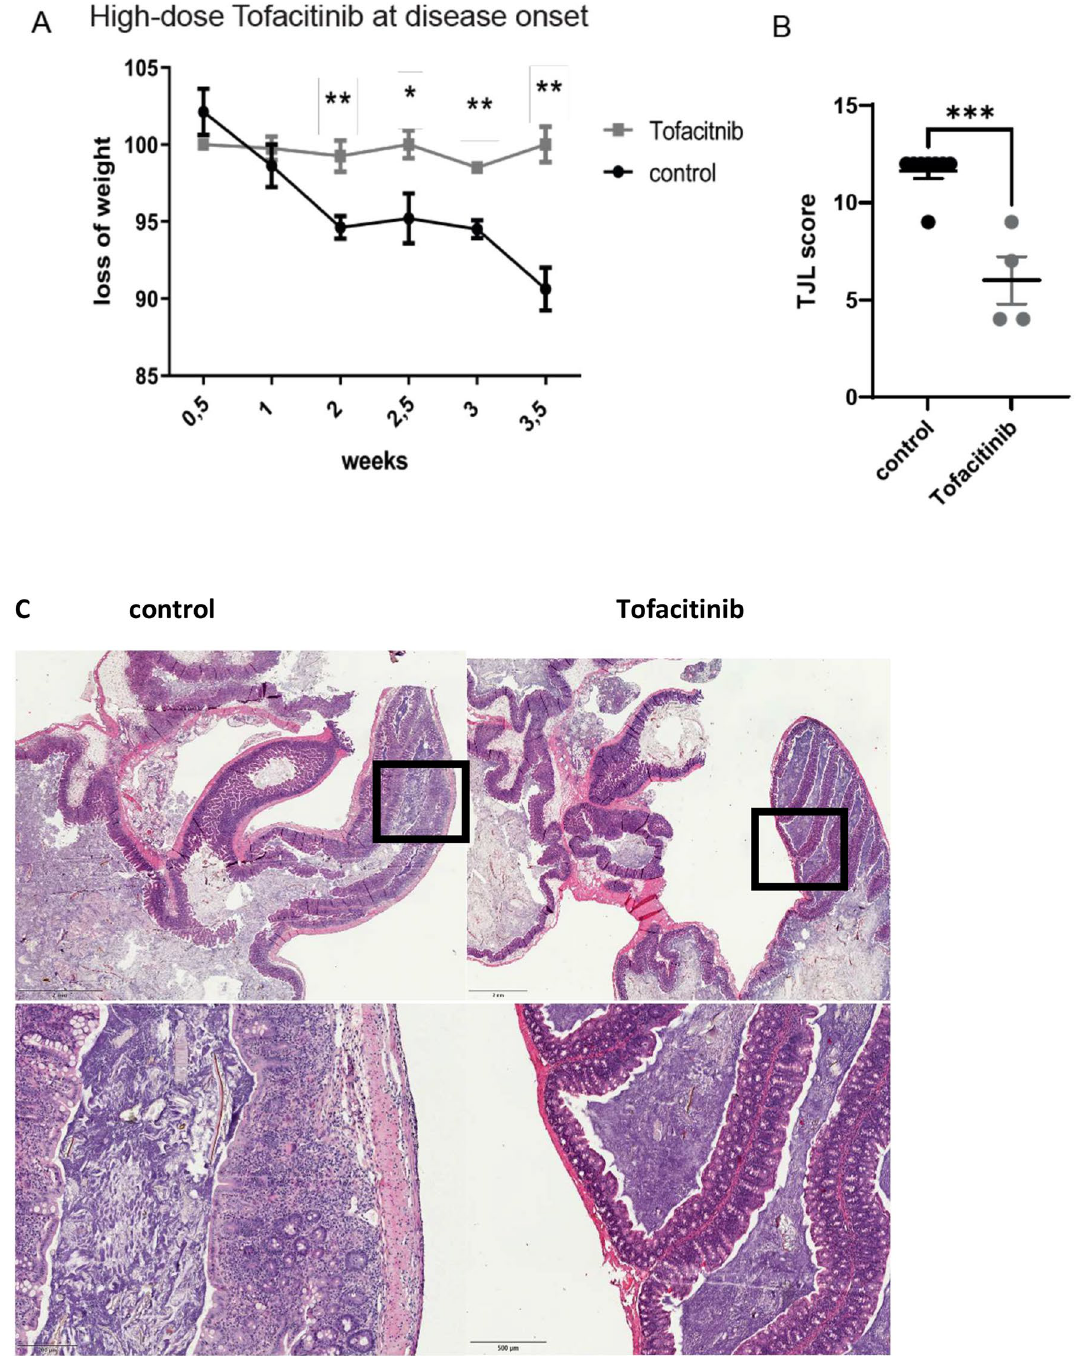
Figure 6. Tofacitinib treatment after onset of colitis reduces weight loss and intestinal inflammation. ( A ) Body weight as a percent of starting weight (N = 8 control mice, 4 Tofacitinib-treated mice, two-tailed unpaired t-tests were used, one experiment, ** = 0.0044, * = 0.0482, ** = 0.0011, ** = 0.0014). ( B ) Results of histological TJL (The Jackson Laboratory Score) scoring of colon sections. ( C ) Representative histology of colon tissue (left: control, right: Severity: Focally small or widely separated multifocal areas of inflammation limited to the lamina propria were graded as mild lesions (1). Multifocal or locally extensive areas of inflammation extending to the submucosa were graded as moderate lesions (2). If the inflammation extended to all layers of the intestinal wall or the entire intestinal epithelium was destroyed, lesions were graded as severe (3). Hyperplasia: Mild hyperplasia consisted of morphologically normal epithelial lining that was at least twice as thick (length of crypts) as adjacent or con- trol mucosa. Moderate hyperplasia was characterized by the epithelial lining being two- or three-times normal